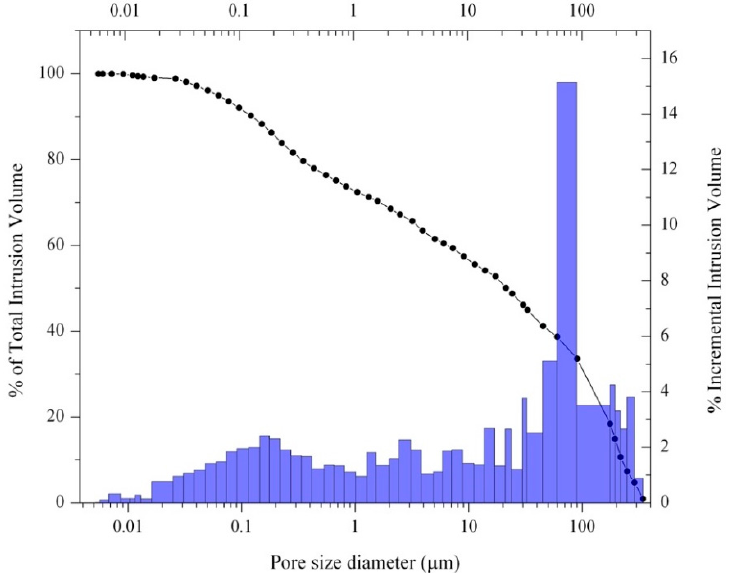
Figure 4 . Pore size distribution curve of a representative specimen of Pietra d’Aspra (not consolidated and not weathered, sample PA-TQ). Left y -axis = % of total intrusion volume (line); right y -axis = % of incremental intrusion volume (bars).